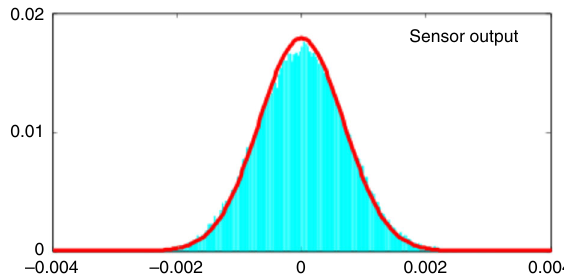
Fig. 8 Kalman model validation based on sensor output. Histogram (cyan) of observed sensor output innovation and Kalman estimates collected over a period of 0.35 s, compared to the zero-mean Gaussian distribution with computed sensor output estimation error (red lines). Probe power = 2 mW, ν = 1.3 kHz. L